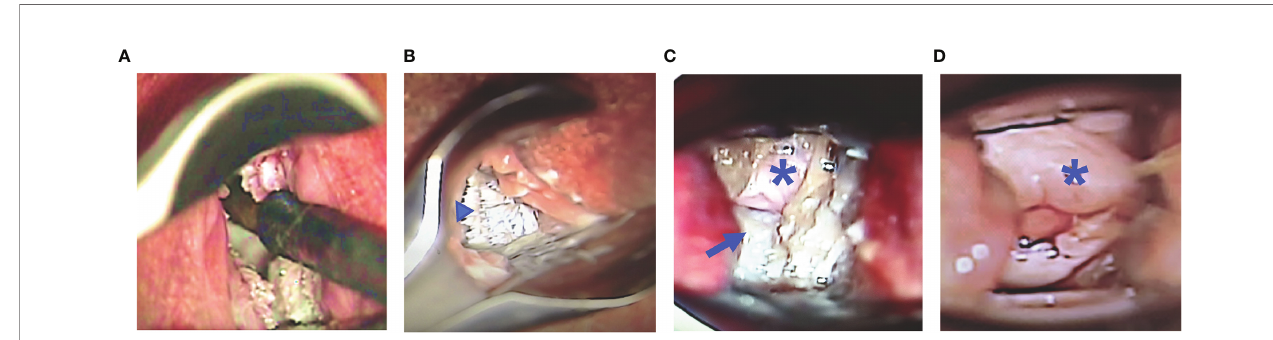
FIGURE 1 | Baseline Colposcopy Findings - use of nasal speculum vaginally for visualization of the cervicovaginal and guidance for optical coherence tomography (OCT) image collection (A) . Representative images of the macaque vagina (arrowhead), fornix (long arrow), and cervix (asterisk) viewed through colposcope. The vaginal mucosa is bright white, with pointed fi nger-like projections and rugations (B) , while the cervix is white-pink and smoother (C) in a nonmensing macaque. Menstrual blood can be seen at the cervical os, while the cervical mucosa is pink and smooth in a mensing macaque